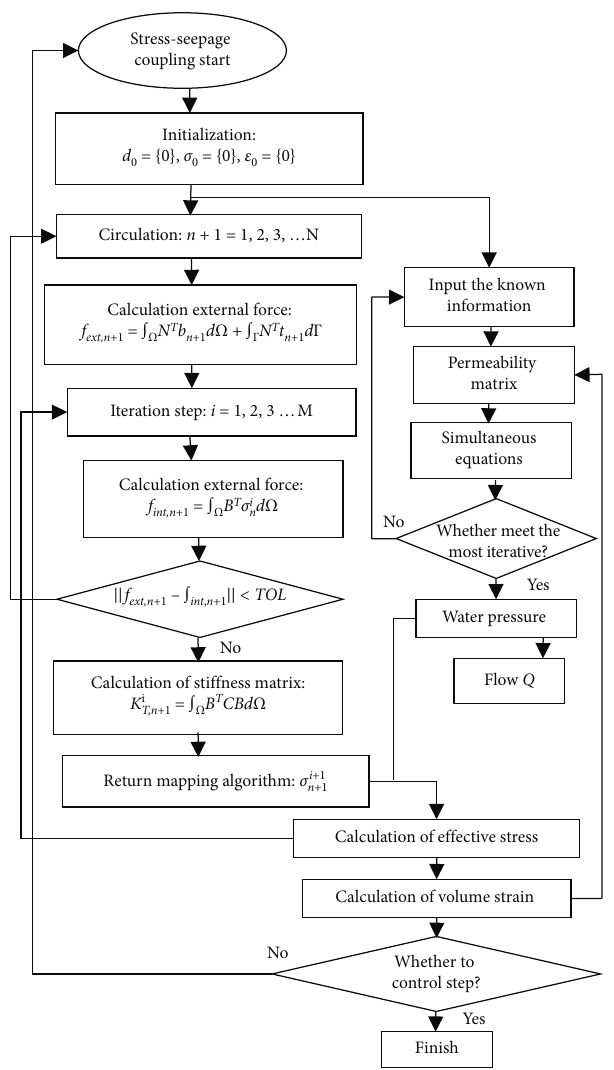
Figure 3: Elastic-plastic stress-seepage-damage coupling